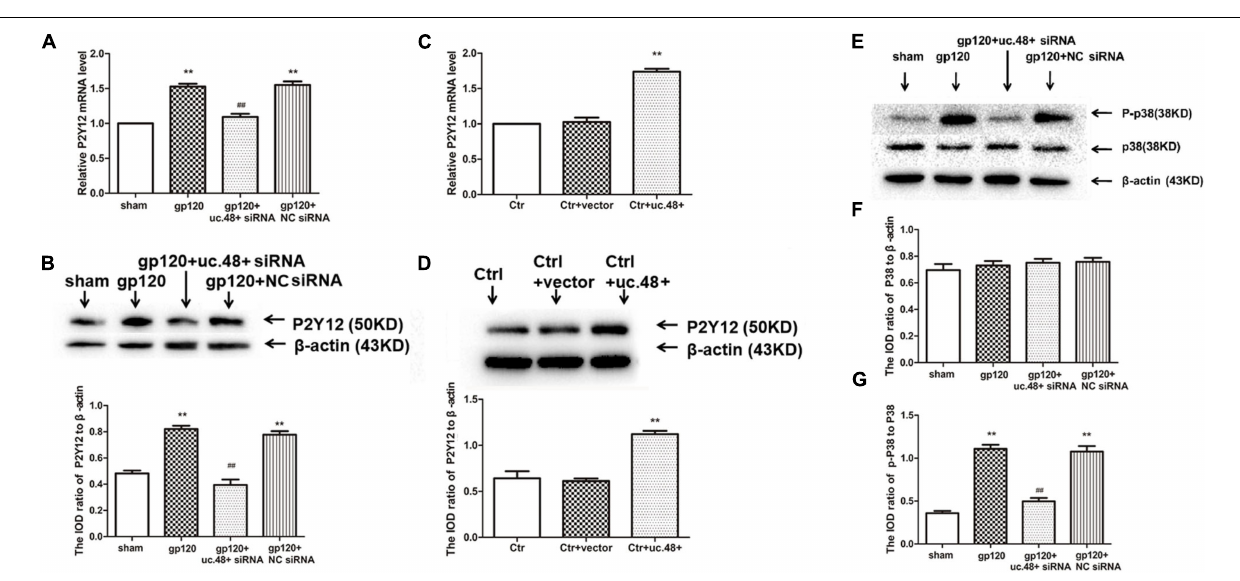
FIGURE 4 | Effects of uc.48+ on P2Y12 receptor expression and activation of P2Y12 downstream P38 MAPK pathway in vivo . Real-time PCR (A) and Western blotting (B) analyses showed siRNA silencing of uc.48+ downregulated P2Y12 receptor expression. n = 10 rats per group. Data are displayed as means ± SEM. ∗∗ p < 0.01 vs. sham group, ## p < 0.01 vs. gp120 group. Real-time PCR (C) and Western blotting (D) results showed that overexpression of uc.48+ upregulated P2Y12 receptor levels in control rat DRG. n = 8 rats per group. Data are displayed as means ± SEM. ∗∗ p < 0.01 vs. control group. (E–G) Uc.48+ siRNA lowered upregulated p-P38 MAPK levels in gp120 group. n = 10 rats per group. Data are displayed as means ± SEM. ∗∗ p < 0.01 vs. sham group, ## p < 0.01 vs. gp120